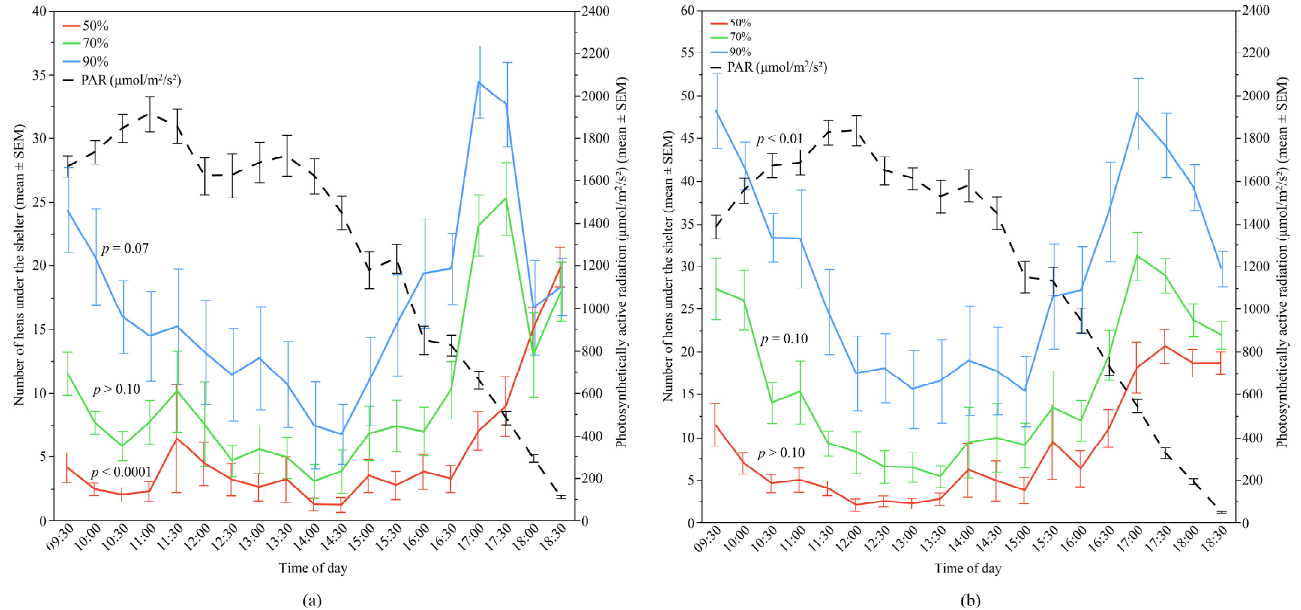
Figure 9. The mean (±SEM) number of hens under the different UV-filtering shelters (50%, 70%, and 90%) and the mean (±SEM) photosynthetically active radiation (PAR) throughout the day: ( a ) Flock- A; ( b ) Flock-B ( p > 0.10 indicates the variable had no significant effect and was removed from final model). Note the different Y-axis scales between Flock-A and Flock-B. Raw values are presented with analyses conducted on transformed data.